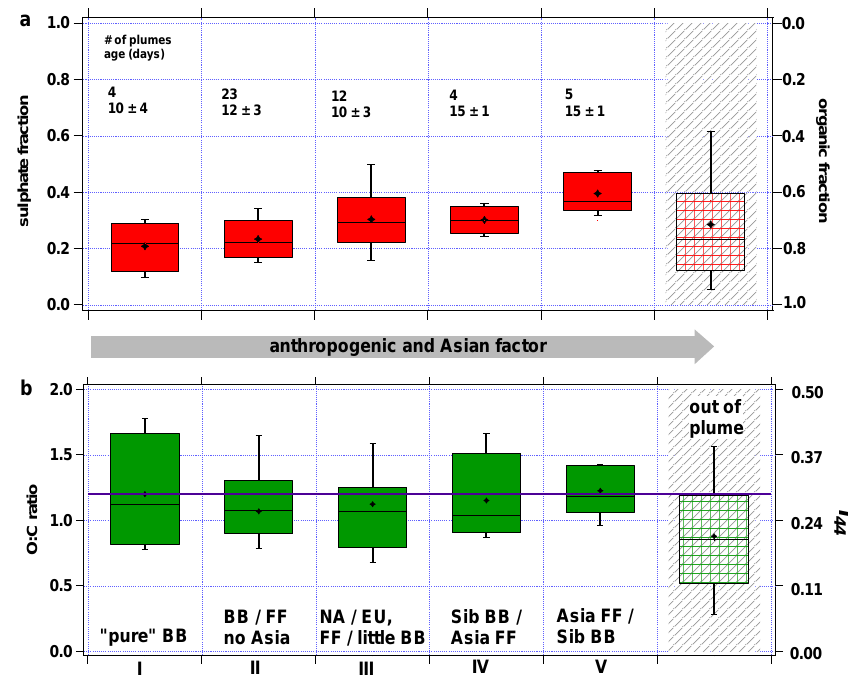
Fig. 11. (a) Fraction of particulate sulphate/organics associated with the type of pollution plume, and measurement periods without plume influence. The boxes denote the 25th and 75th percentiles, the black line within the box represents the median and the error bars show the 10th and 90th percentiles. The black stars denote the average value. (b) Oxygen to carbon ratio (O:C ratio), same notation as top panel, f 44 denotes the fraction of m/z 44 of total organic mass. The purple line shows the oxygenation maximum after Ng et al. (2010). The roman numbers identify the plume